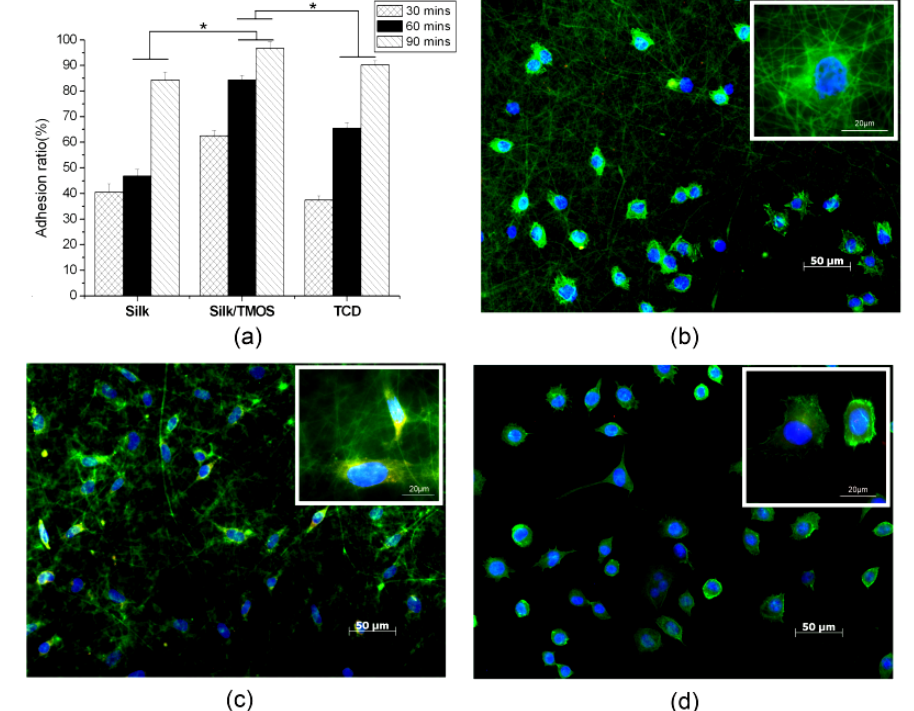
Figure 6. The adhesion ratio for L929 cells after 90 min culture on pure silk, silk/TMOS nanofibers and tissue culture dishes (TCD) controls ( a ). Significant difference between different materials groups were denoted as * (p < 0.05). Fluorescent staining of F-actin (green), vinculin (red), and cell nuclei (blue) for L929 cells after 6 h culture on silk: fibrous scaffold (b ), silk/TMOS ( c ), and TCD ( d